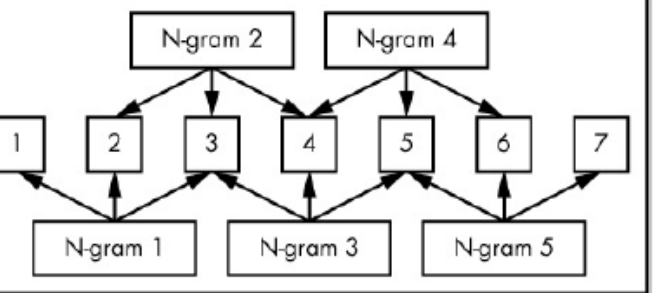
Figure 6. N-gram extracted from ransomware samples. Adapted with permission from Ref. [30].